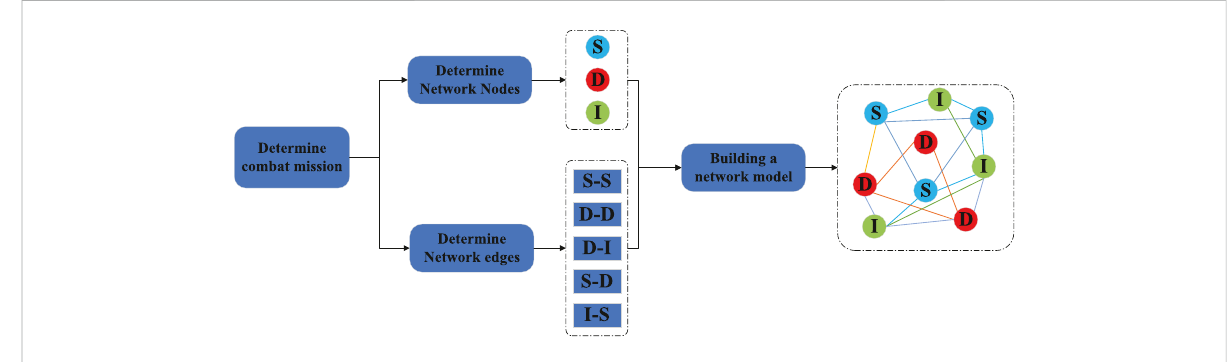
FIGURE 4 Modeling steps of heterogeneous combat network. Firstly, determining the combat objectives according to the combat tasks and determining the nodes and edges of the combat network. Finally, the combat network model is generated from the nodes and the edges identi fi ed by the information fl ow.